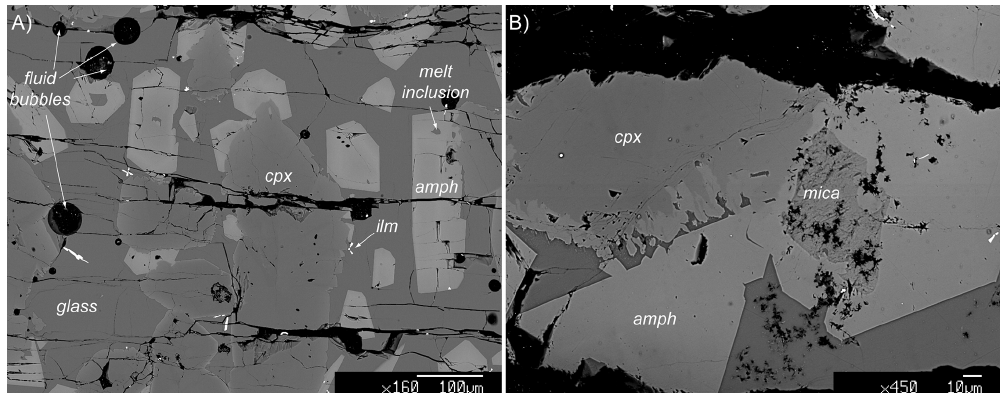
Figure 3. Representative backscattered electron (BSE) images showing the key textural relationship in experimental runs. Clinopyroxene (cpx) is always infiltrated by the melt matrix and partially overgrown amphibole (amph). Amphibole shows a polygonal habit, suggesting chemical equilibrium with the surrounding glass matrix. Sometimes small pockets of melt inclusion and former crystals of mica are present within amphibole crystals. Ilm: ilmenite. (a) Experiment 17-4C, (b) experiment